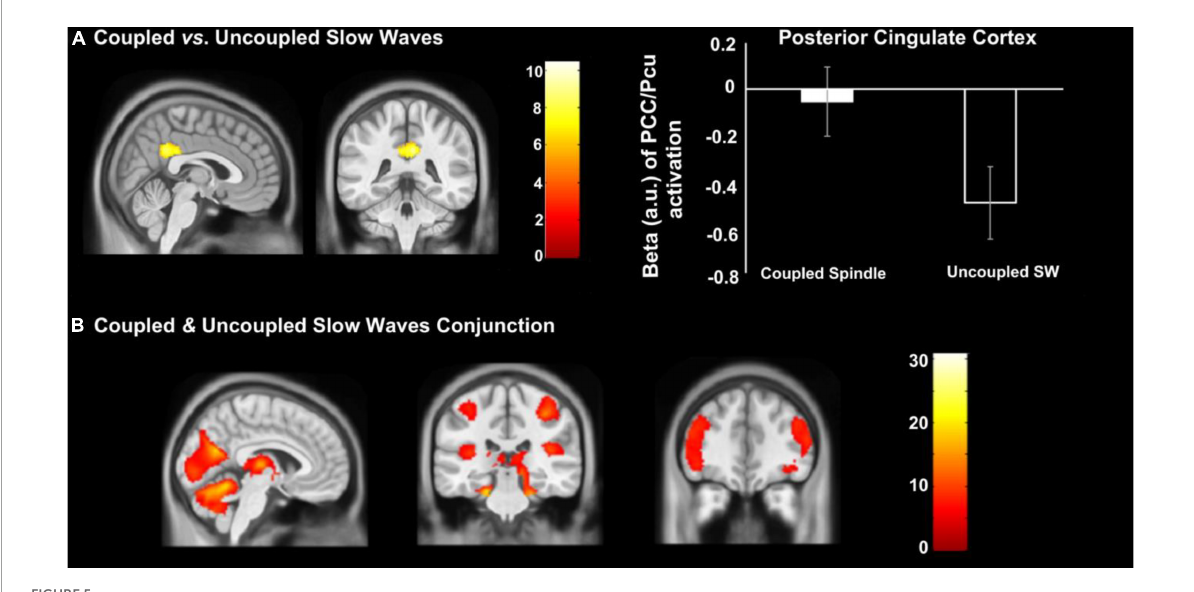
FIGURE5 Differences in cerebral activation between (A) coupled vs. uncoupled slow waves, and (B) conjunction between coupled and uncoupled slow waves. Statistical inferences were performed at p < 0.05, FWE was corrected at the cluster level.